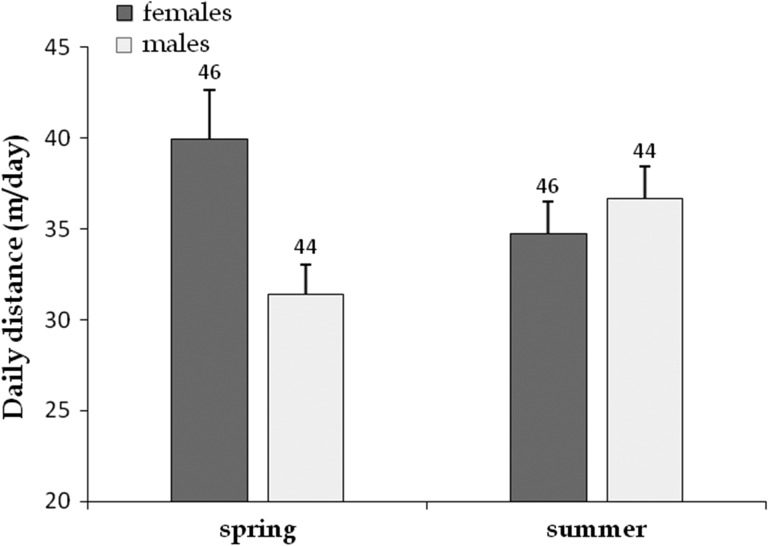
Effect of sex and season on the mean (+SEM) daily displacements of radio-tracked Hermann's tortoises. Two periods were considered: spring (left side), which corresponds to vitellogenesis and laying periods, and summer (right side), which corresponds to the main season of sexual activity in males. We found significant effects of sex and season, and a significant interaction between these factors (see Table 1).